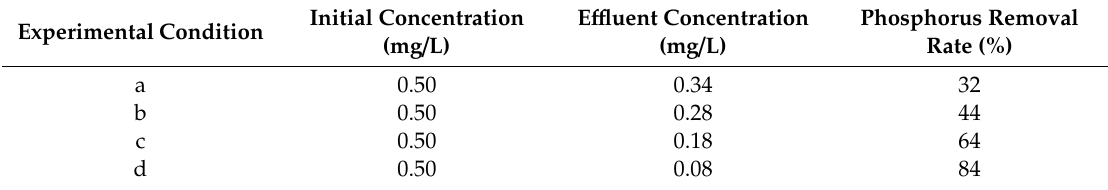
Table 6. E ff ect of experimental condition in reactor on phosphorus